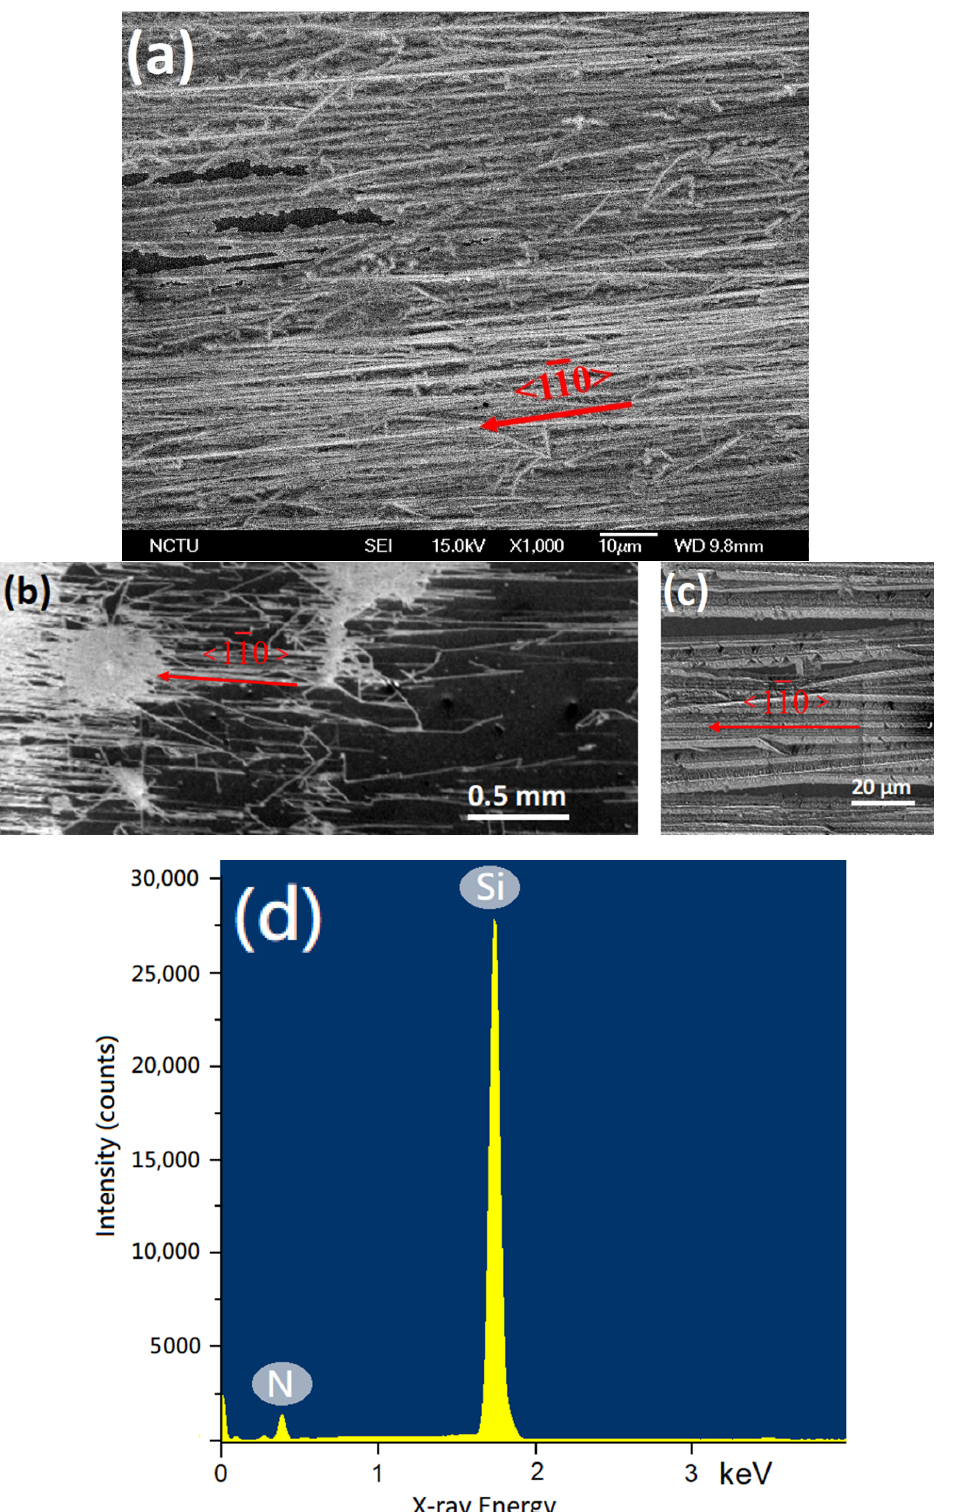
Figure 1. SEM surface morphology after nitriding for ( a ) 10 min and ( b ) 20 min. ( c ) Enlarged view of a dense region. ( d ) EDS spectrum of